Question: Describe this figure in one sentence.
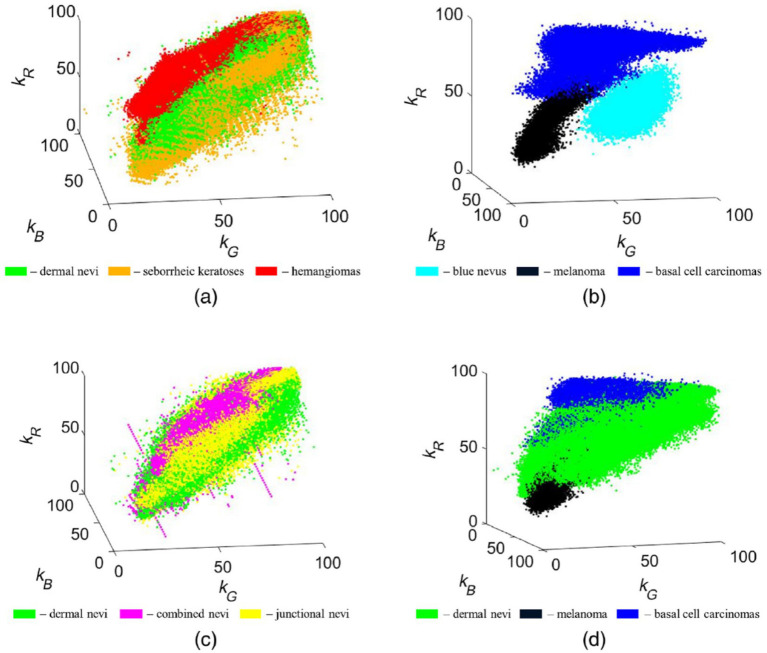
Answer: 3D graphs of the three attenuation coefficients (in %) for different groups of skin lesions: dermal nevus, seborrheic keratosis and hemangioma (a) , blue nevus, melanoma and basal cell carcinoma (b) , dermal, combined and junctional nevus (c) , dermal nevus, melanoma and basal cell carcinoma (d) ( 18 ).